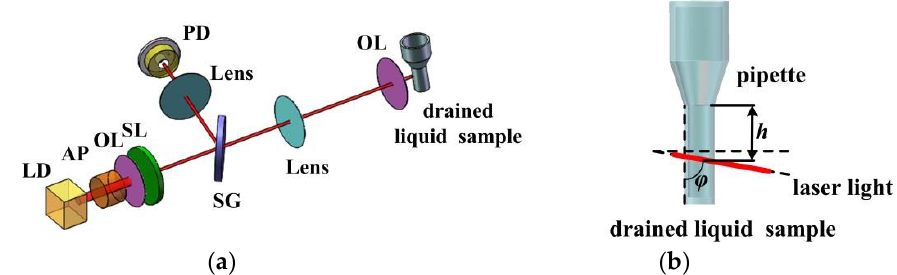
Figure 10. ( a ) Experimental setup. LD, laser diode; AP, anamorphic prism pair; OL, objective lens; SL, Nd:GdVO 4 solid-state laser; SG, slide glass; PD, photodiode receiver; PC, personal computer. ( b ) Configuration used to detect drained suspension. (Figure reproduced from Ref. [64]).